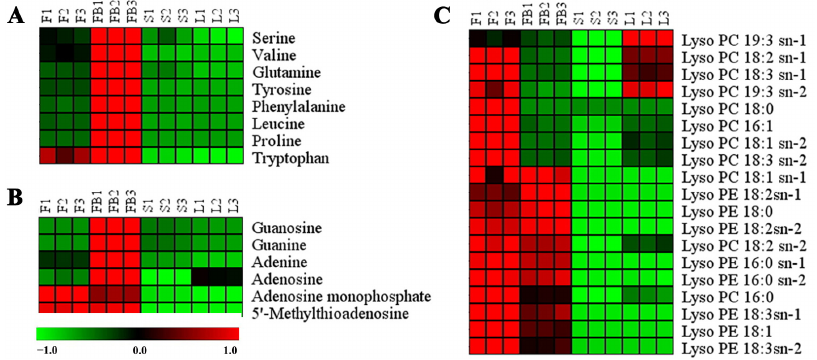
Figure 4. Heat map of differential primary metabolites. ( A ) amino acids. ( B ) nucleosides. ( C ) lipids. Red represents higher content and green represents lower content.